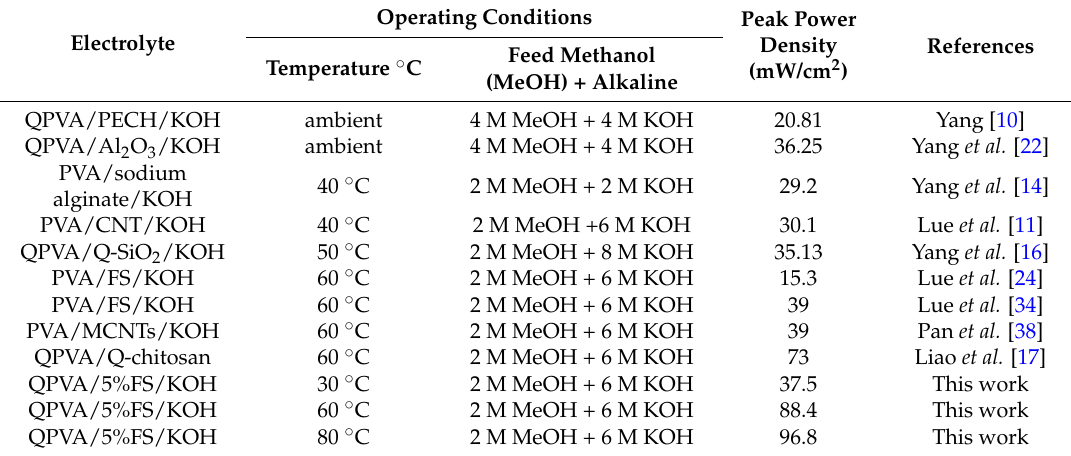
Table 2. Comparison of peak power densities obtained for direct alkaline methanol fuel cells in previous